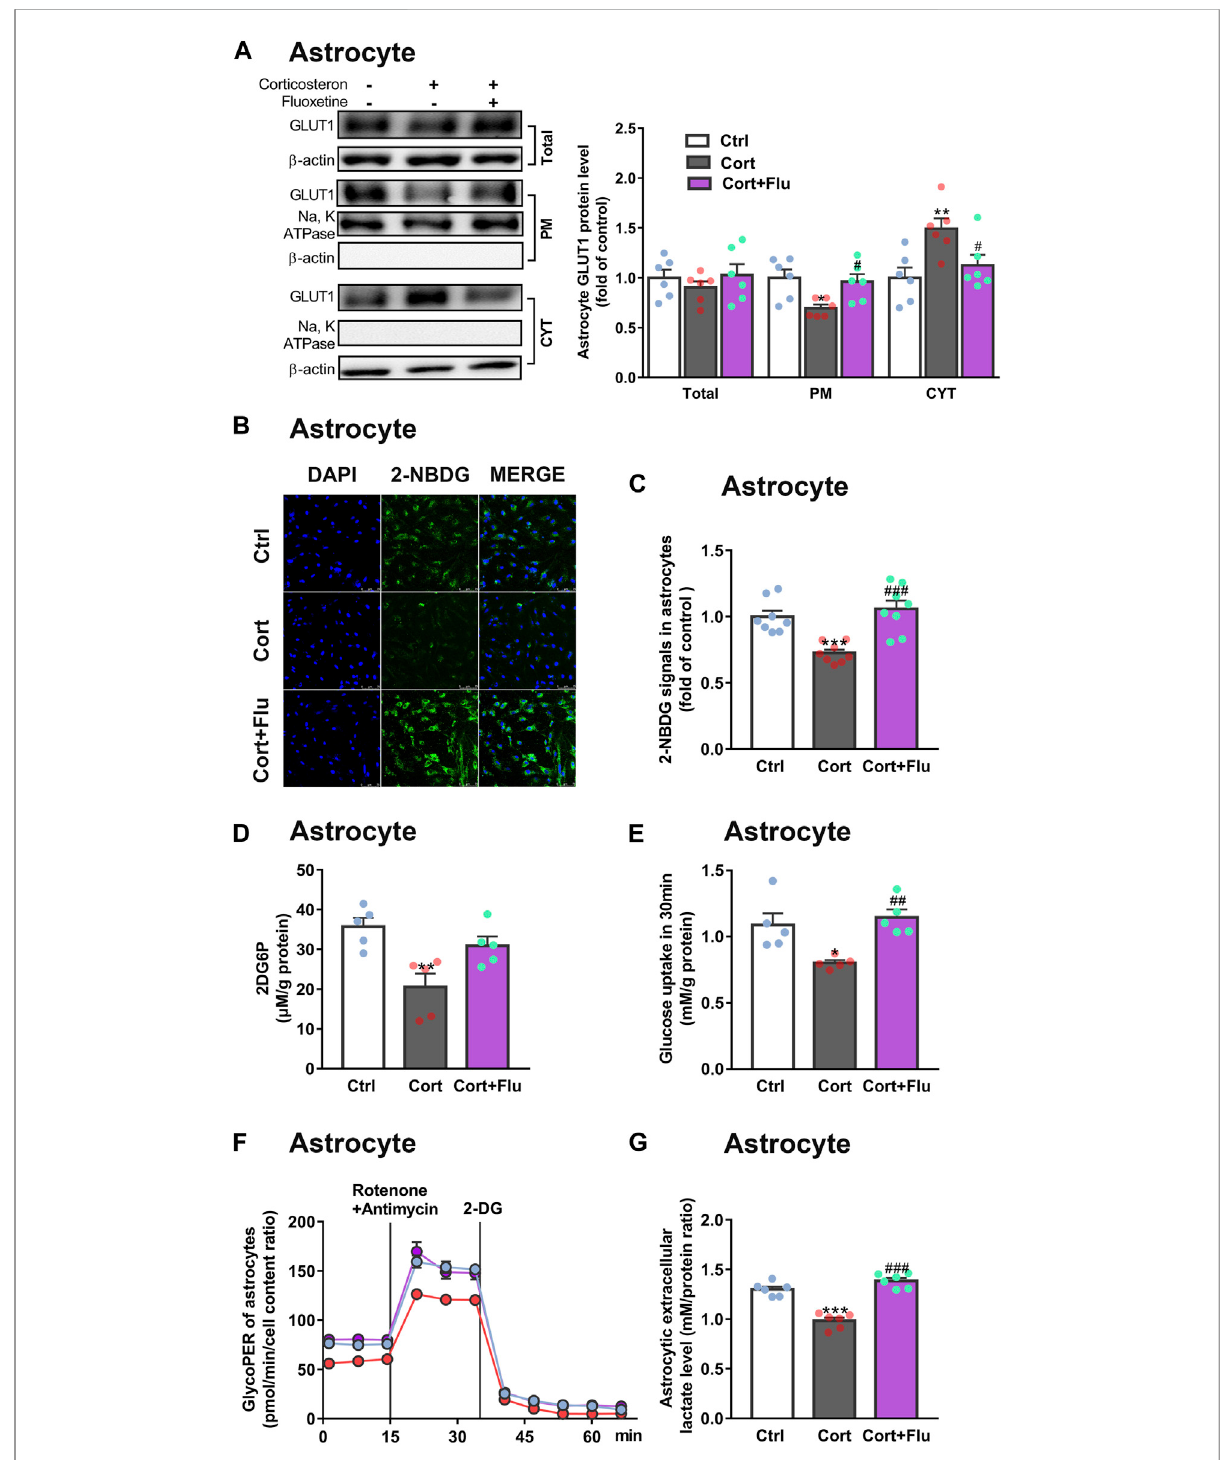
FIGURE 4 Fluoxetine increases glucose uptake and glycolysis in primary astrocytes cultured with corticosterone in vitro . (A) GLUT1 (total, PM and CYT fractions) protein levels in fl uoxetine (5 μ M)-treated primary astrocytes (72 h), n = 6 cell cultures/group; Total: P CortxCort + Flu = 0.5093; PM: P CortxCort + Flu = 0.0287; CYT: P CortxCort + Flu = 0.0435. (B,C) 2-NBDG uptake in astrocytes treated with fl uoxetine (5 μ M) were imaged by confocal microscopy [ (B) , scale bar = 75 μ m)] or measured by microplate reader [ (C) , n = 8 cell cultures/group)]; P CortxCort + Flu = 0.0001. (D,E) 2-DG [ (D) , n =5cellcultures/group; P CortxCort+Flu=0.1125)]orGlucose [ (E) , n =5cellcultures/group; P CortxCort+Flu=0.0043)]uptake by astrocytes treated with fl uoxetine (5 μ M) in 30 min (F,G) GlycoPER [ (F) , n = 6 cell cultures/group)] and lactate release [ (G) , n = 6 cell